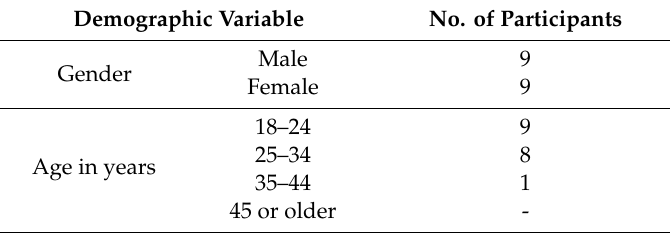
Table A1. Demographics of the